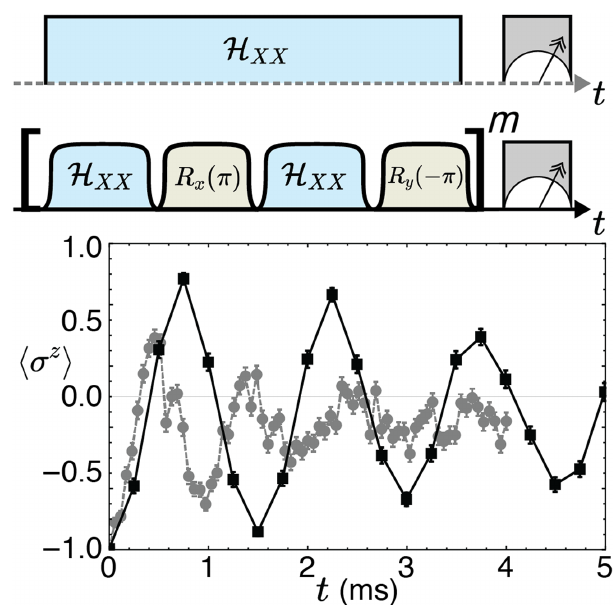
FIG. 2. An example of dynamical decoupling for a two-ion interaction. Direct evolution of the average ion magnetization, (cid:10) σ z (cid:8) , under H XX (gray dashed line) is quickly damped due to slow dephasing noise from fluctuating Stark shifts. In compari- son, the dynamical decoupling scheme [Eq. (19)] consisting of alternating π pulses about the x and y axes (black solid line) preserves coherence to substantially longer times, even after accounting for the slowing of the averaged interactions, without otherwise altering the intended dynamics. Each point represents the mean of 300 experimental repetitions, with error bars of 1 SEM (standard error of the mean). The experimental parameters used here are t p = 20 µ s, t 1 = 120 µ s, and δ/η(cid:6) =